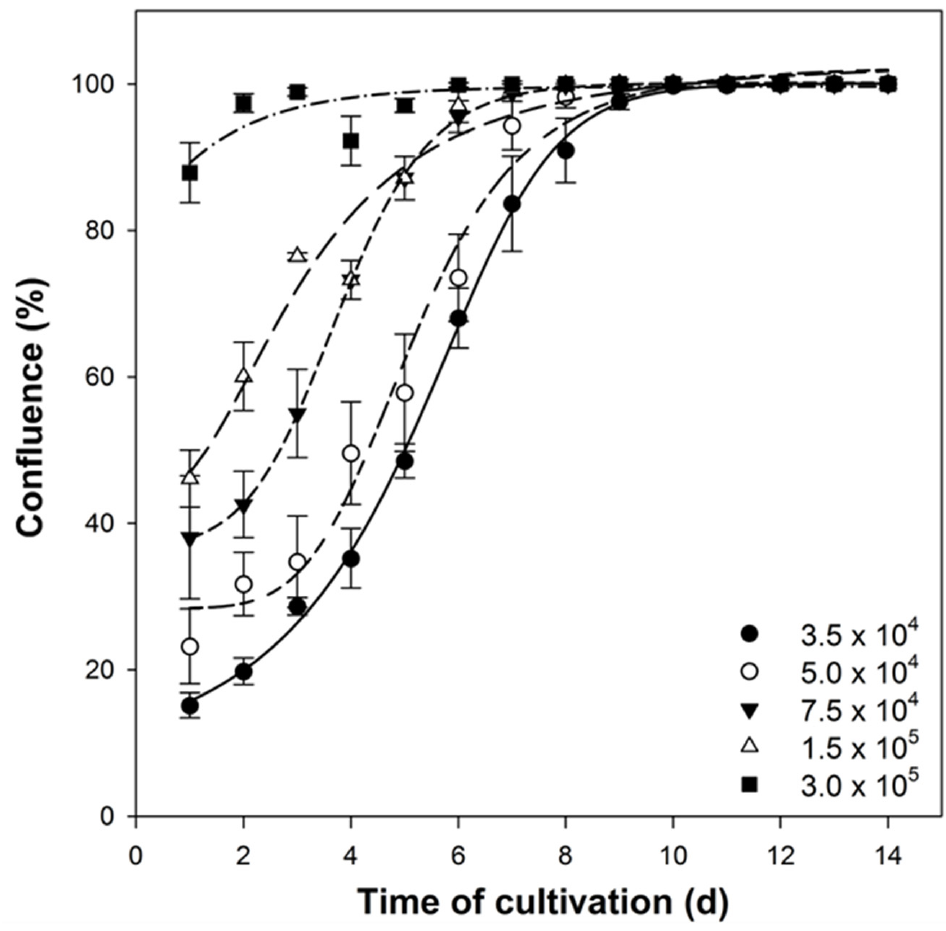
Figure 3. Confluence of SH-SY5Y over a cultivation period of 14 days. Cells were seeded with initial densities of 3.0 × 10 5 cells/cm 2 , 1.5 × 10 5 cells/cm 2 , 7.5 × 10 4 cells/cm 2 , 5.0 × 10 4 cells/cm 2 , and 3.5 × 10 4 cells/cm 2 . Confluence was analyzed by bright field live-cell imaging with a microscope stationary within the incubator. (Regression coefficient for the curve adaptions for 3.0 × 10 5 cells/cm 2 : r 2 = 0.9721; for 1.5 × 10 5 cells/cm 2 : r 2 = 0.9701; for 7.5 × 10 4 cells/cm 2 : r 2 = 0.9811; for 5.0 × 10 4 cells/cm 2 : r 2 = 0.9881; and for 3.5 × 10 4 cells/cm 2 : r 2 = 0.9913.)